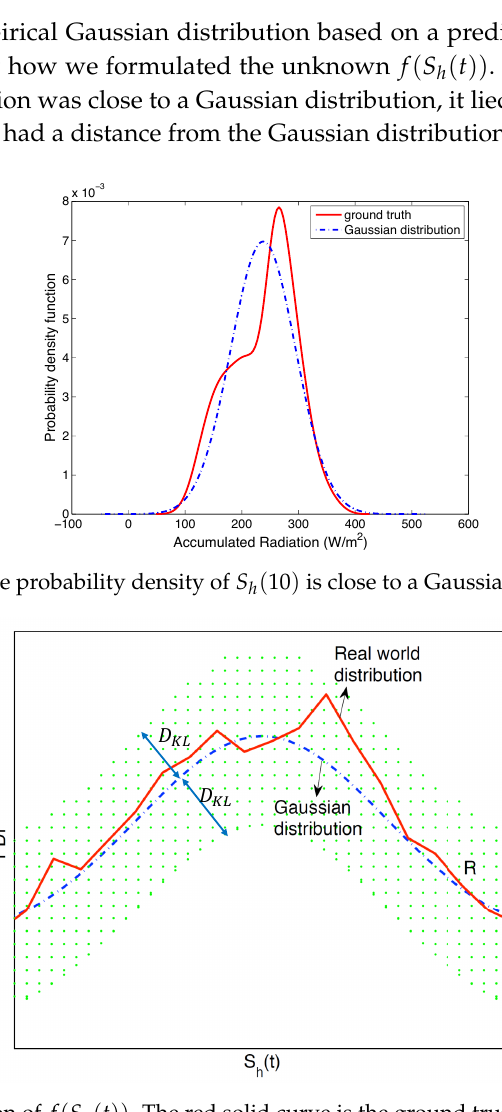
Figure 3. The formulation of f ( S h ( t )) . The red solid curve is the ground truth PDF, which is unknown in practice. The blue dotted curve is an empirical Gaussian distribution. The dotted area denotes R in which each distribution has a distance from the Gaussian distribution lower than a limit D KL . Since the ground truth distribution is close to the Gaussian distribution, we say that the ground truth distribution belongs to R . Please note that this figure is for illustrative purposes